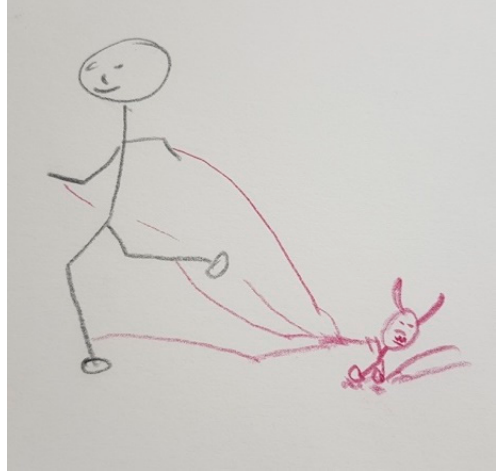
Figure 3. P5’s perception of PD.